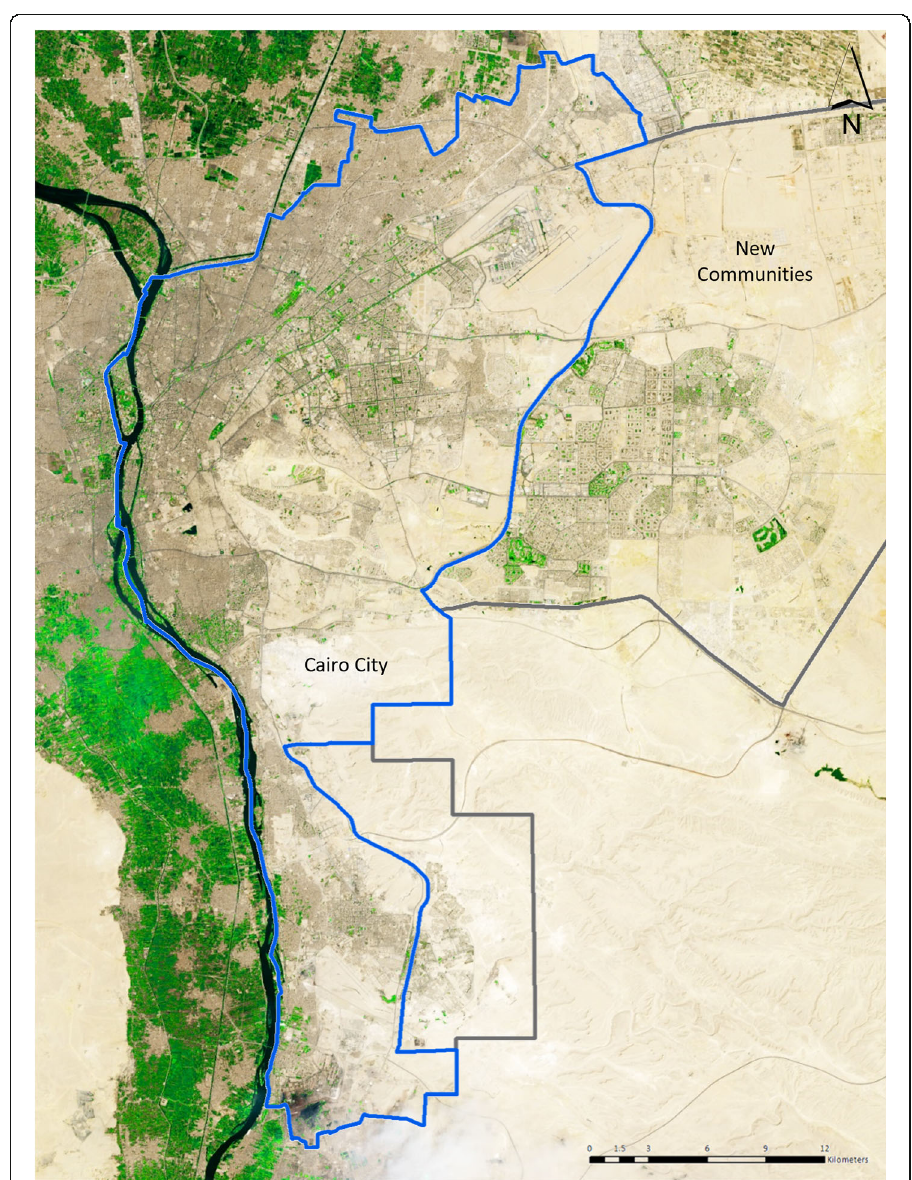
colour was changed to show the green spaces more clearly. Original satellite image is from Nasa Earth Observartory —